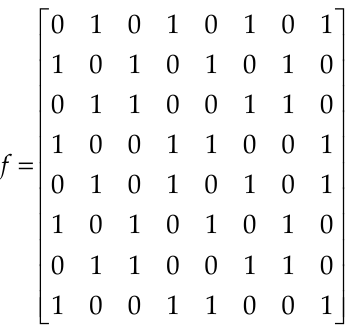
Figure 9. Joint factor matrix.